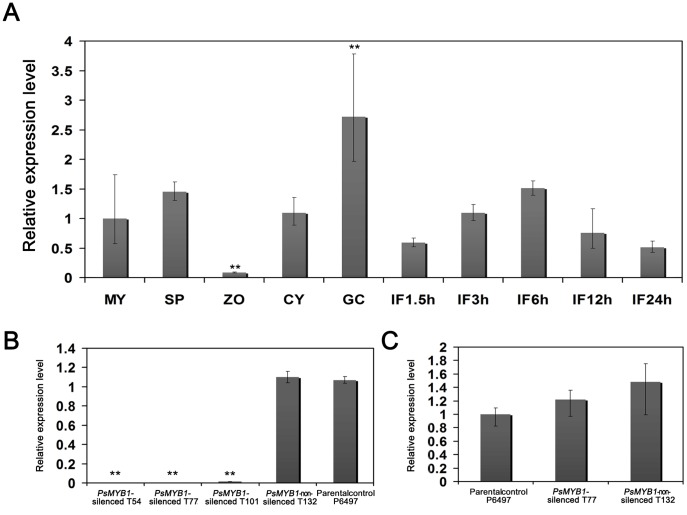
qRT-PCR assay of the PsMYB1 gene.(A) Expression pattern of PsMYB1 based on qRT-PCR. The ten stages are: mycelia (MY), sporulating hyphae (SP), zoospores (ZO), cysts (CY), germinating cysts (GC), and IF1.5 h to IF24h (samples from 1.5, 3, 6, 12, and 24 h after infection of soybean leaves). (B) Expression of PsMYB1 in strains transformed with extra copies of PsMYB1. qRT-PCR was performed using sporangiating hyphae RNAs from wild-type isolate (P6497) and transformants (PsMYB1 silenced, T54, T77, and T101; PsMYB1 non-silenced, T132) as initial template. (C) PsSAK1 expression level in the PsMYB1-silenced line. qPCR was performed based on the ΔΔCT method. Error bars are calculated from three replicate qRT-PCR assays.